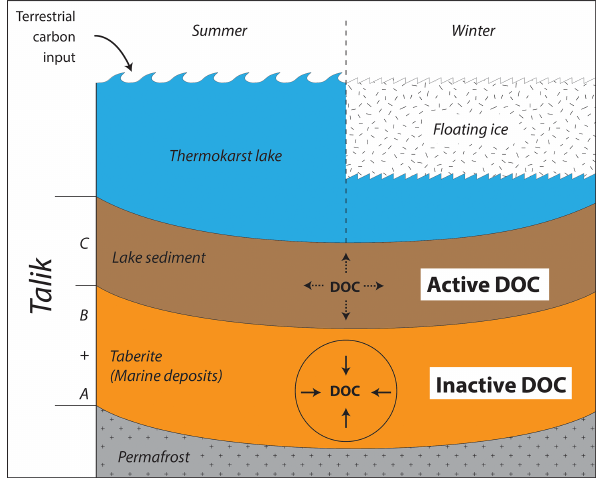
Figure 7. Conceptual model of DOC dynamics in coastal Alaskan floating-ice thermokarst lake taliks. The uppermost facies of organic-rich lake sediments is an active part of the carbon cycle and appears to undergo high levels of degradation (active DOC). The taberite facies of the former permafrost soil also build up high DOC concentrations but appear to be less affected by degradation (inactive